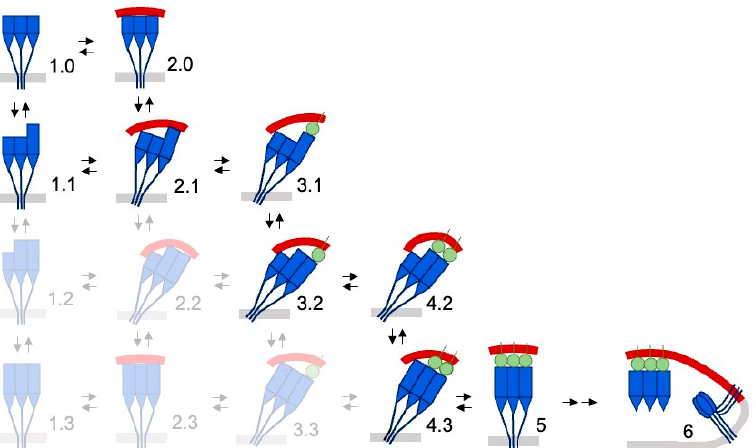
Figure 1. Hypothetical model of host cell membrane binding by Omicron subvariant spikes. A network of spike states based on Omicron subvariant structures is shown. Those states populated insufficiently to be seen by cryo-EM are whited out. The unbound RBD modules flicker between up and down states (tall and short blue rectangles, respectively) to yield open state 1.1. Additionally, drawn are the NTDs (blue triangles) and C-terminal remainder of the S subunits (blue line) that span the viral membrane (light grey bar). The host cell membrane (red) is engaged in states 2 and above of the spike trimer structure, which are predicted to prefer binding to concave membranes. The membrane-tethered spike trimer can bind a single ACE-2 receptor (green circle) on the host cell surface in state 3, a second ACE-2 molecule in state 4, and a third ACE-2 molecule to form prefusion state 5. This leads to proposed state 6, where ACE-2-spike complexes stabilize the membrane contact site while a cleaved spike trimer inserts into the host cell surface, drawing it close to the viral membrane to merge lipid bilayers [44] . Adapted from [11] .